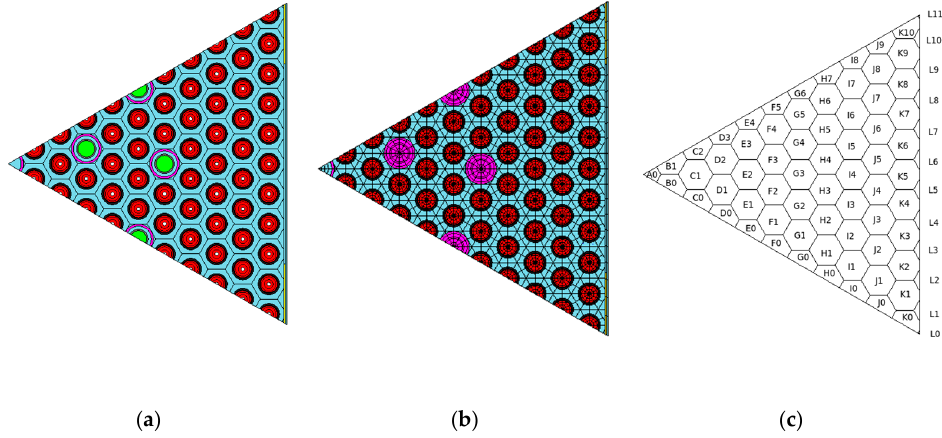
Figure 5. Different calculation meshes drawn on a sector of VVER FA showing 60 o rotational sym- metry. ( a ) Self-shielding mesh with material color map. ( b ) Flux calculation mesh with temperature color map. ( c ) Homogenization grid with lexicographic naming scheme.